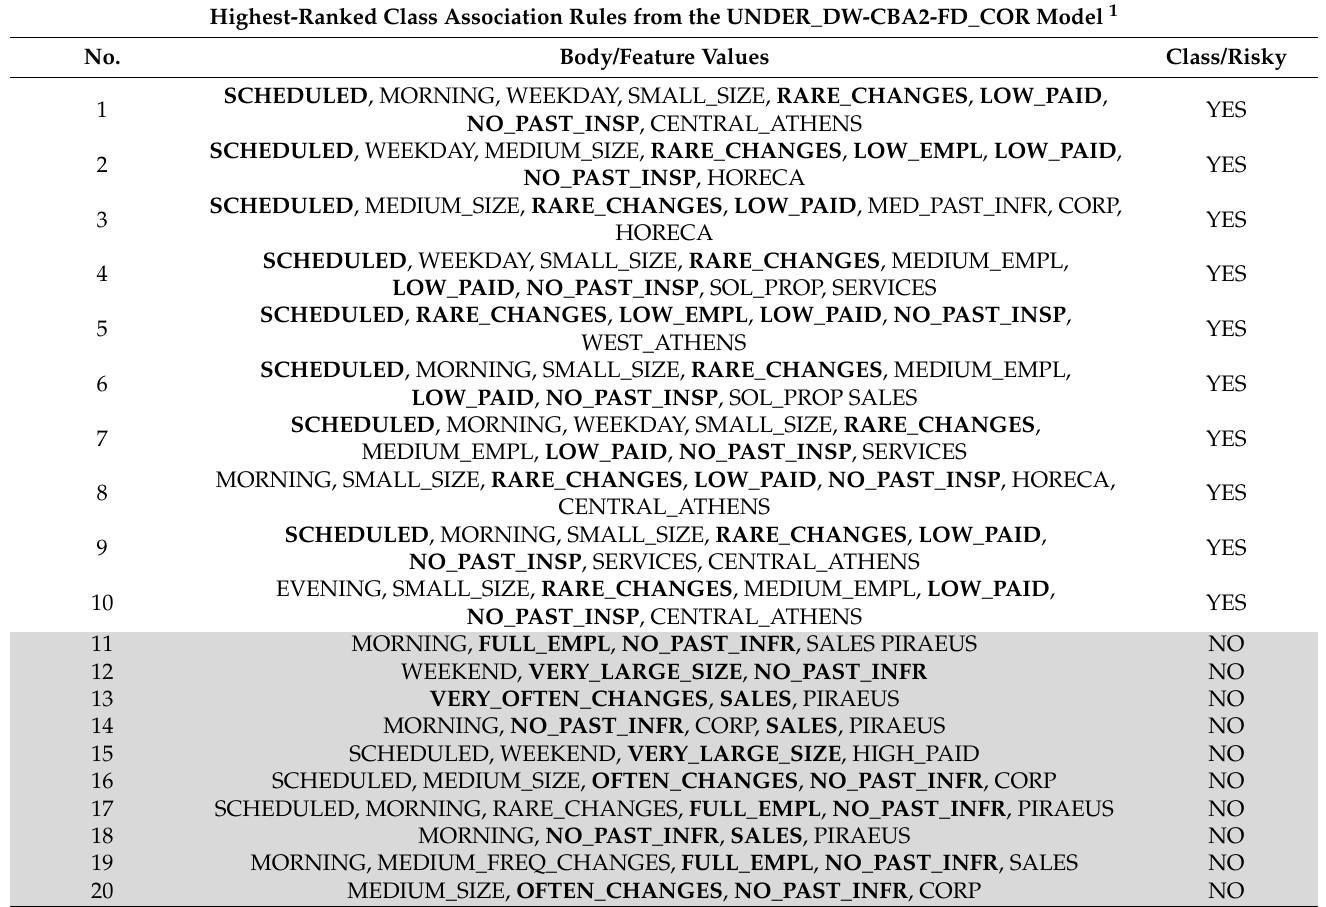
Table 14. Prevailing patterns of compliance and non-compliance as regards underdeclared